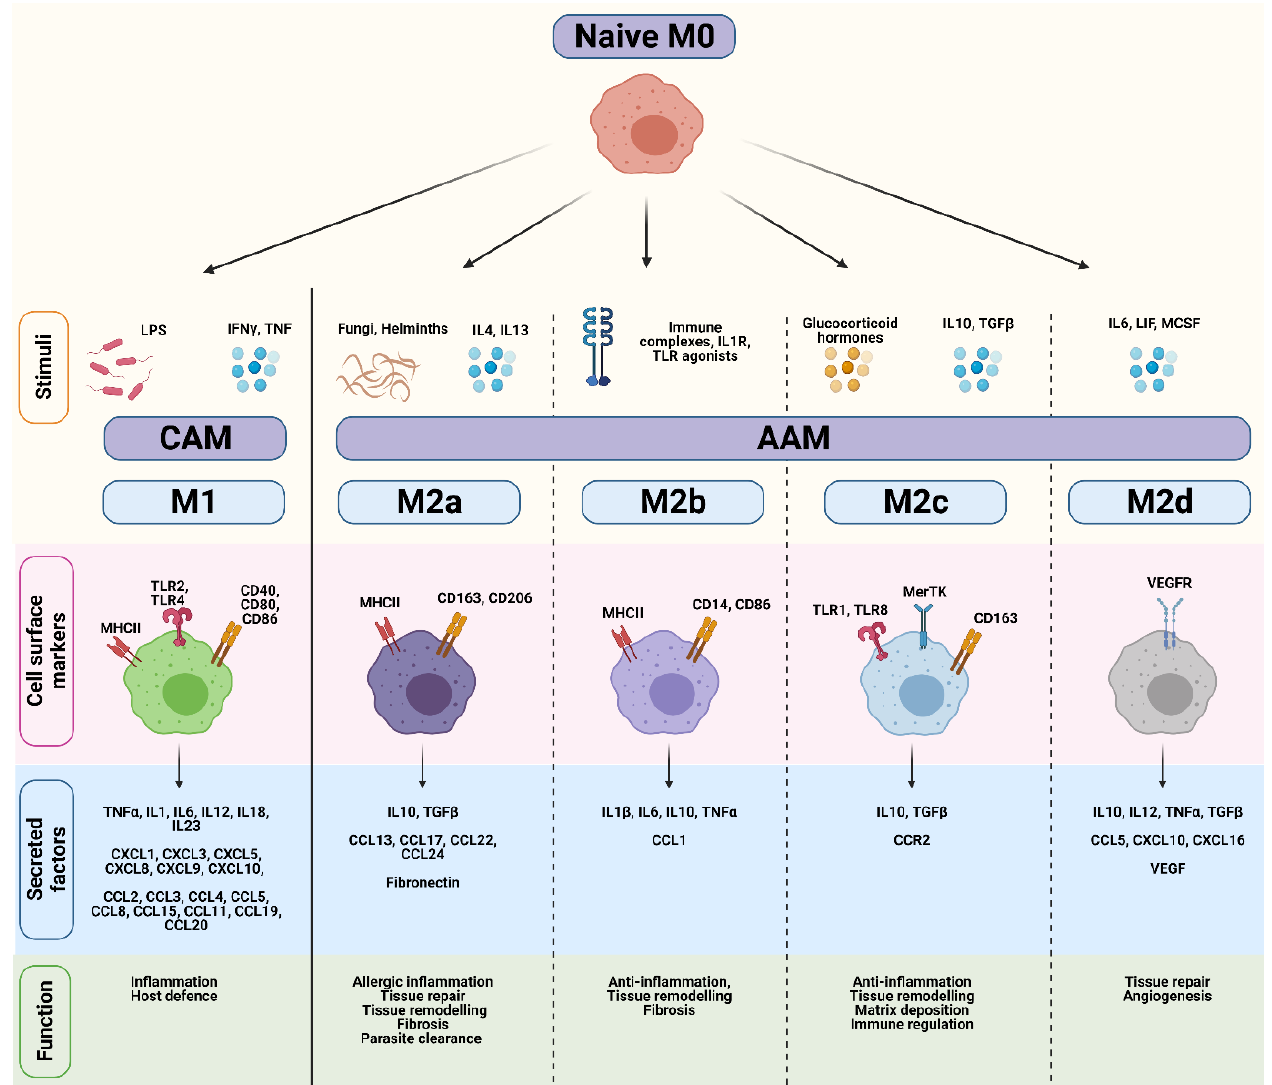
Figure 2. Comparison of CAM and AAM macrophage endotypes. Naïve M0 macrophages differentiate into classically- activated M1 (CAM) or alternatively-activated M2 (AAM) subtypes in response to various stimuli. CAMs and AAMs exhibit distinct surface markers, cytokines, and biological functions. Figure created in Biorender.